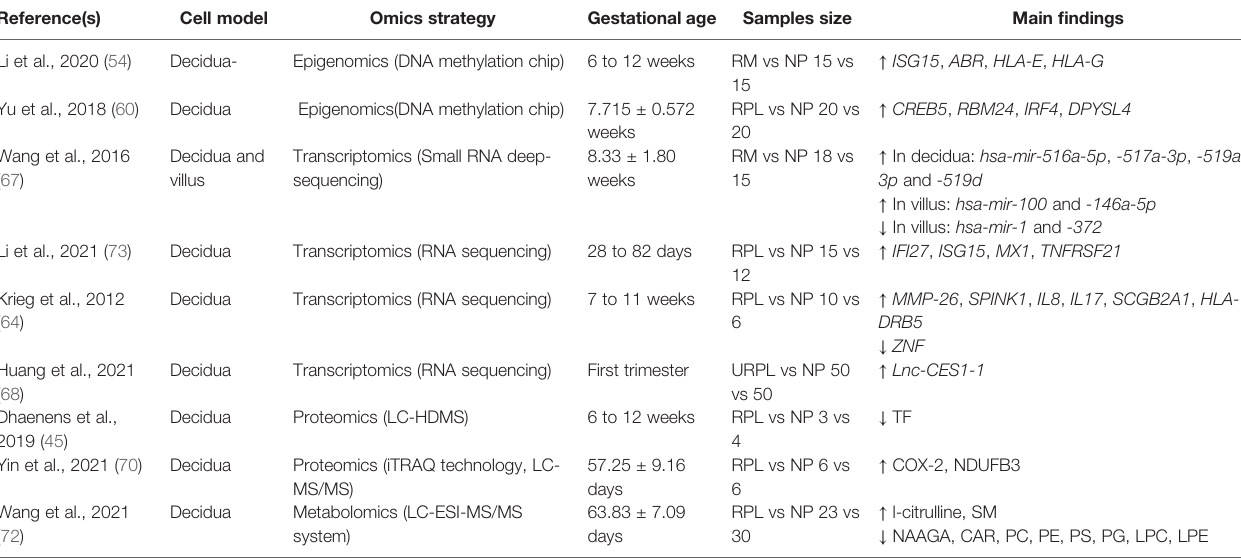
TABLE 1 | Omics studies on decidual tissue of recurrent pregnancy loss patients and